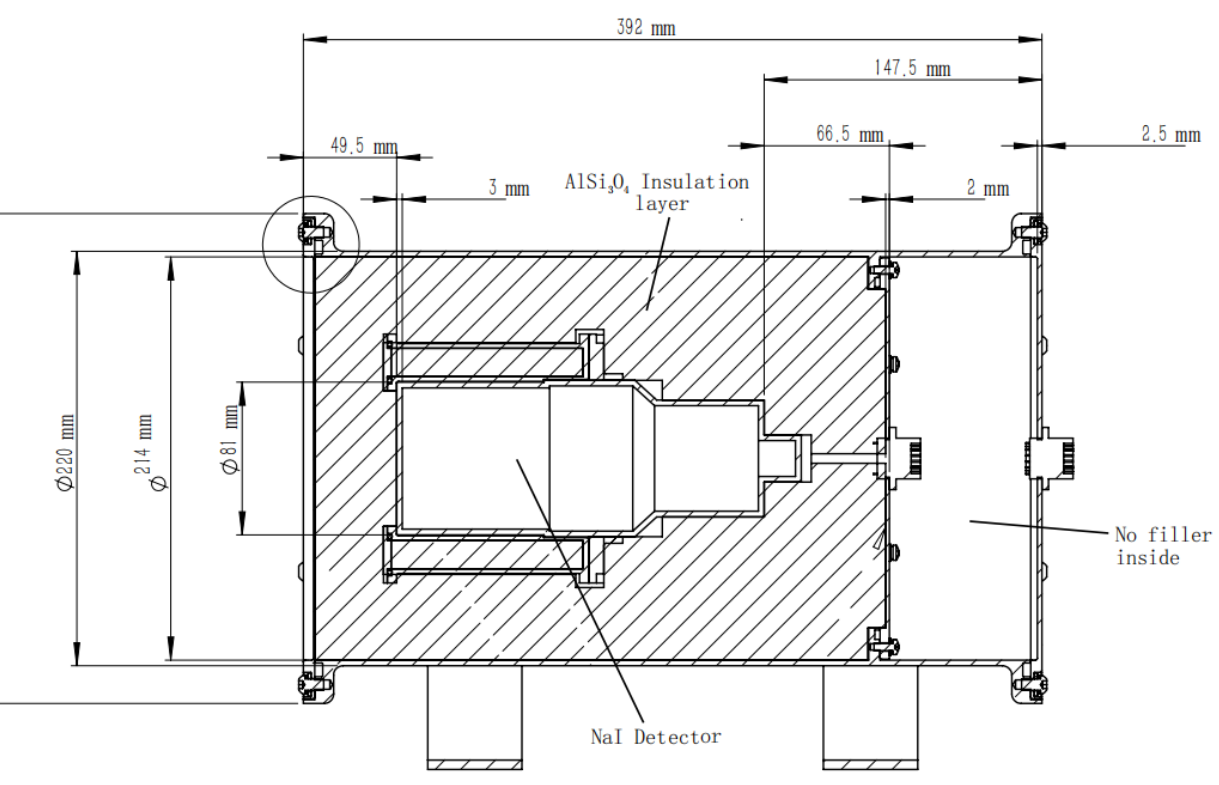
Figure 2. Structure diagram of the NaI detector.